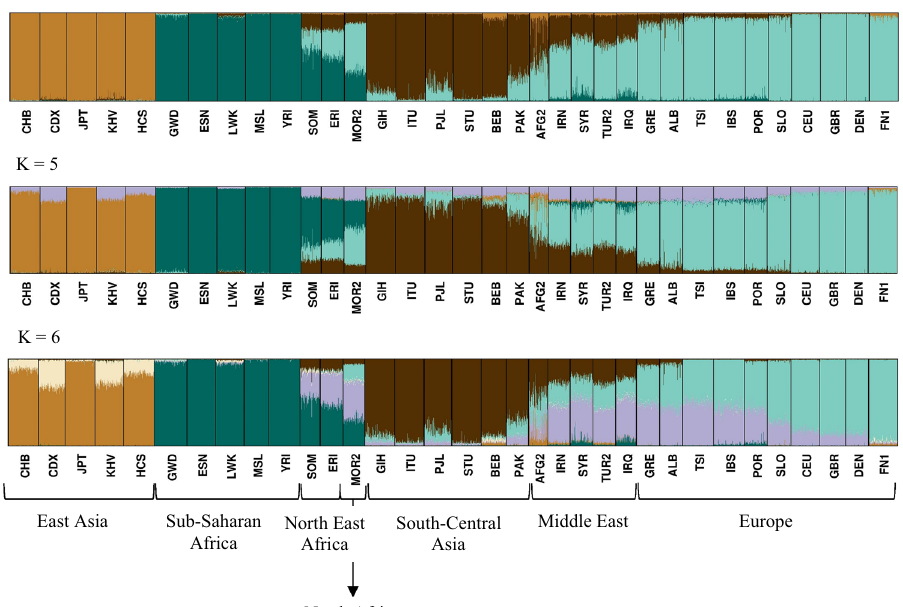
Figure 2. Diagram of the STRU CTU RE analysis with runs of K = 4 to 6 of the combined dataset of 233 AIMs. The reference data are from the 1000 Genomes Project. Population abbreviations are the same as those described in Supplementary Materials Table S2. The membership proportions were plotted using CLUMPP v.1.1.222 48 and Distruct v. 1.1.23 49